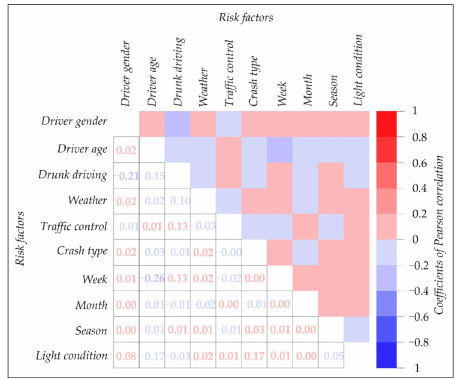
Figure 3. Coefficients of Pearson’s correlation test.